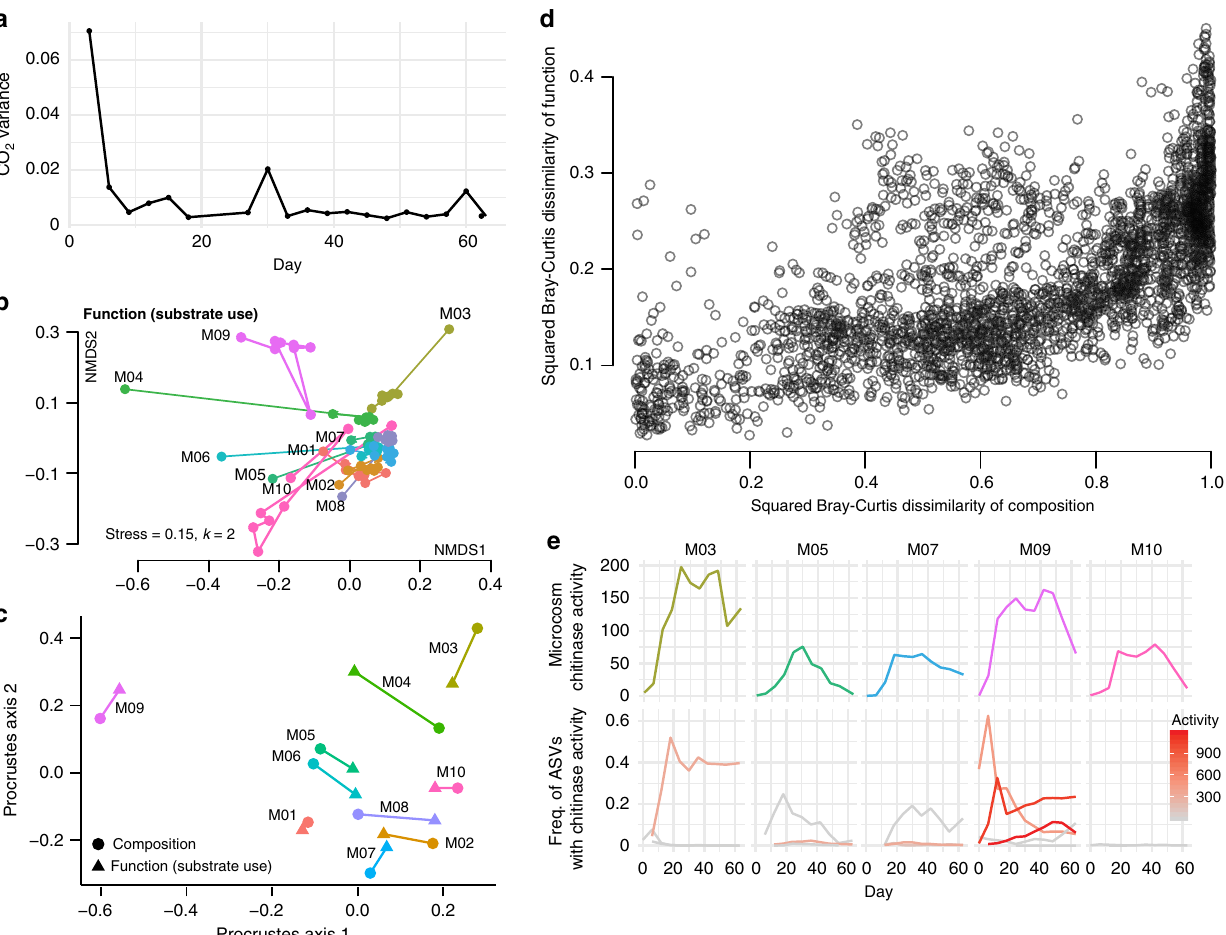
Fig. 4 Community composition strongly correlates with functional activity. a Variance in percent CO 2 among the ten microcosms over the course of the serial transfer experiment. b Two-dimensional NMDS plot of the Bray – Curtis dissimilarities of functional activity (substrate use) as measured by EcoPlates. The microcosm name is listed in black next to the Day 0 point, and the lines connect the timepoints. c Procrustes rotation of the composition NMDS plot with the function NMDS plot for Day 63 (Procrustes correlation = 0.8991, p = 0.001). d Plot of Bray – Curtis dissimilarities in composition between all measured timepoints across all microcosms compared with the dissimilarities in functional pro fi le for the corresponding samples (Mantel test r = 0.6403, p = 1 × 10 − 4 ), squared to better illustrate the spread of points. e Endochitinase activity over time for the fi ve microcosms that strains were cultured from (top row) and frequency of the ASVs over time that map to strains with measurable endochitinase activity (bottom row). Endochitinase activity is shown in units/mL for the strains/ASVs in the bottom row by a gradient from gray (low activity) to red (high